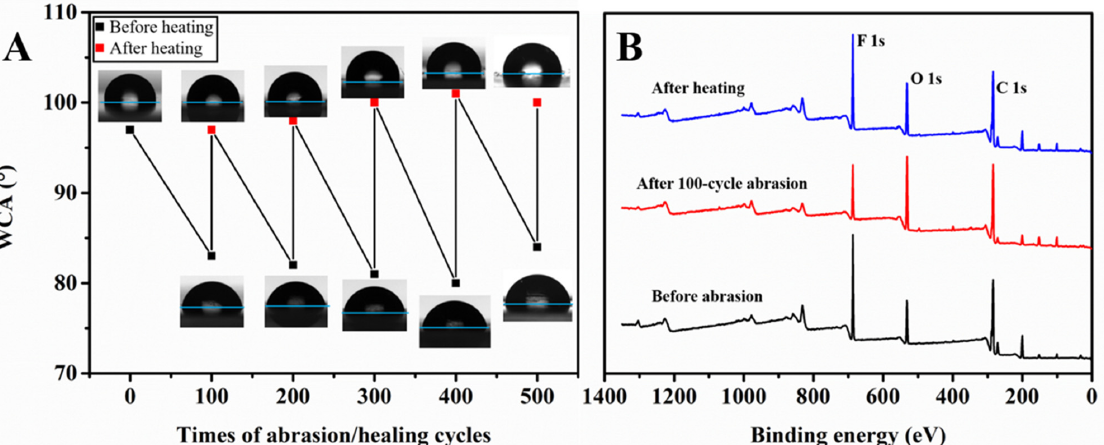
Figure 6. ( A ) Changes in WCAs after repeated abrasion and heat treatment at 80 °C for 2 h; ( B ) XPS spectra of P(CTFE- alt -IBVE)/MFWPU composite coating surface before abrasion after 100 abrasion cycles and after heating.